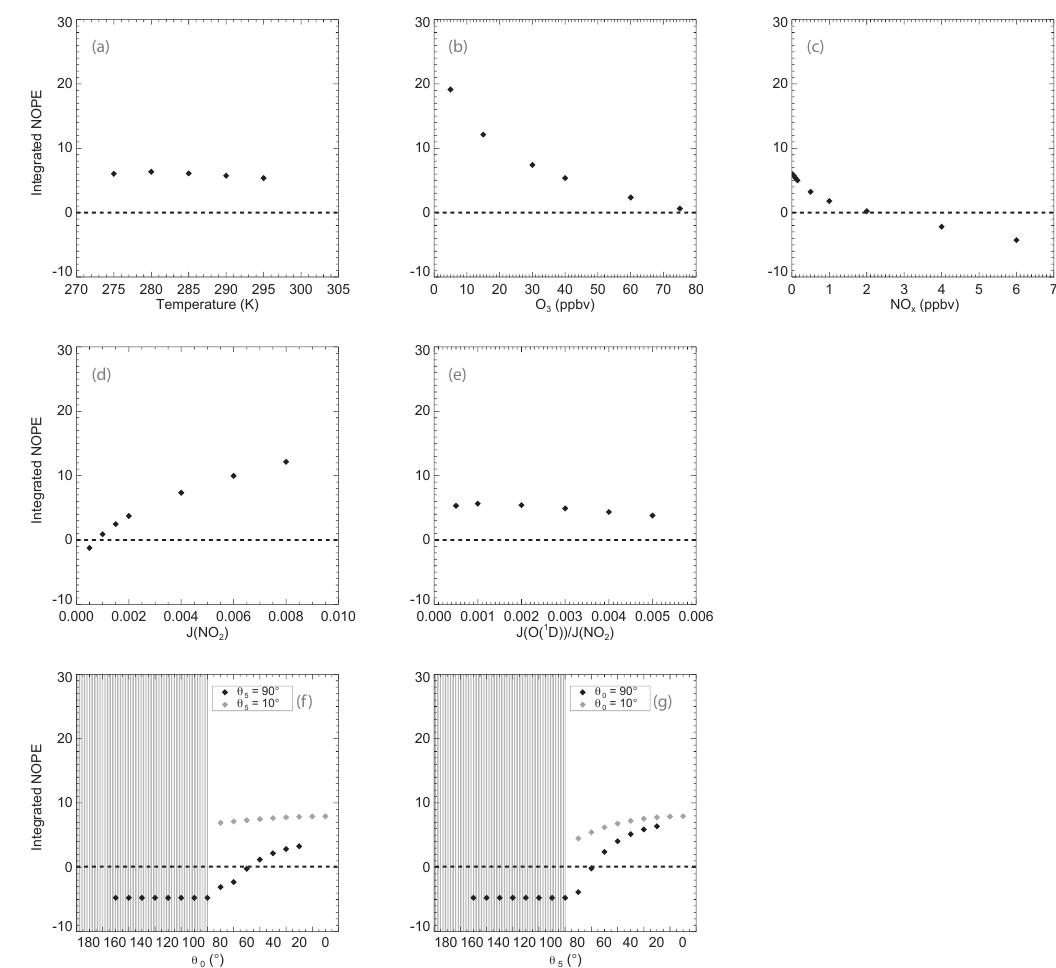
Fig. 3. PARANOX simulations of the integrated net ozone production efficiency (NOPE) after 5h for a plume released at 12:00h local time as a function of: (a) temperature; (b) ambient O 3 concentration; (c) ambient NO x concentration; (d) J( NO 2 ) ; (e) J( NO 2 ) ; (f) θ 0 and (g) θ 5 . The shaded areas in panel (f) and (g) correspond to simulations during darkness. Ambient meteorological conditions and concentrations as in Fig. 2.